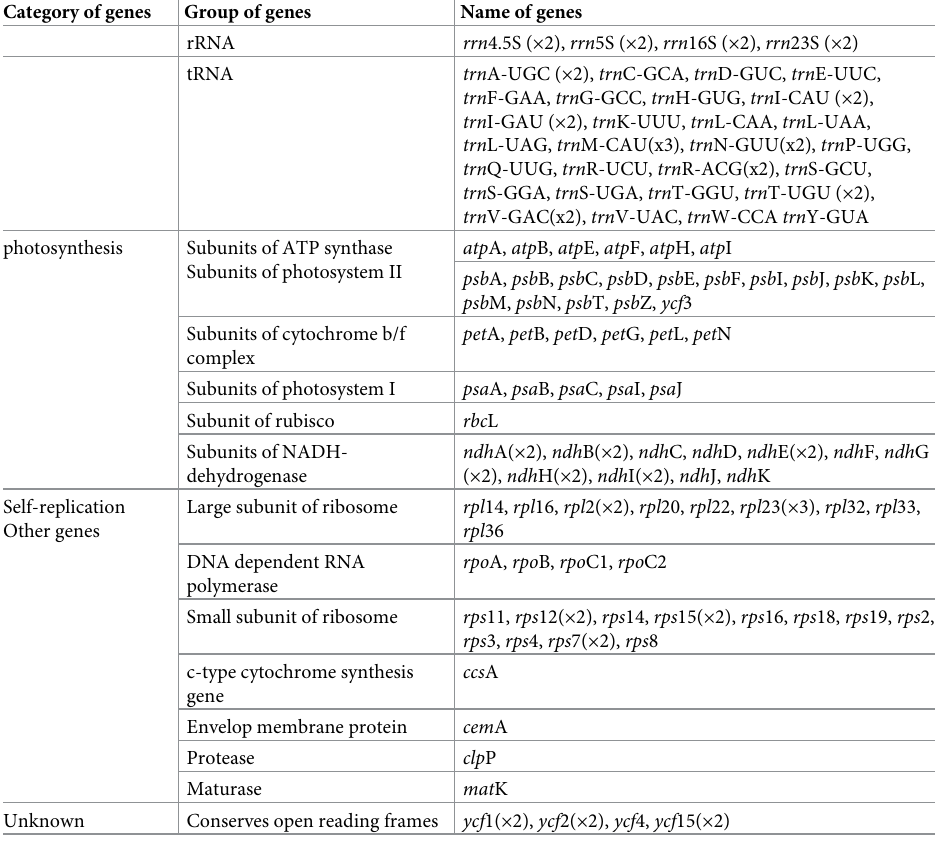
Table 1. Gene compositions of the Codonopsis pilosula subsp. tangshen